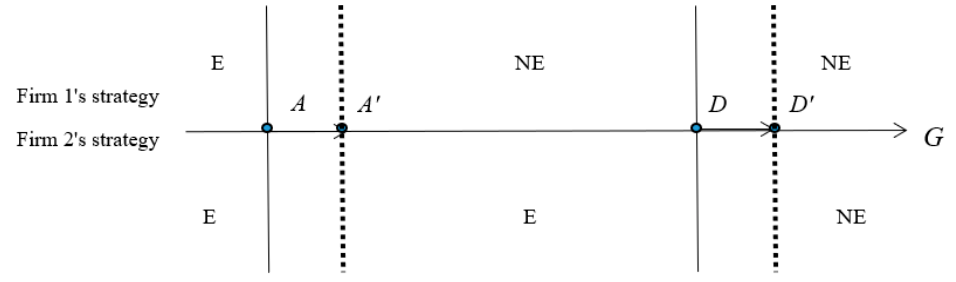
Figure A2. Changes in the export decisions due to a lower